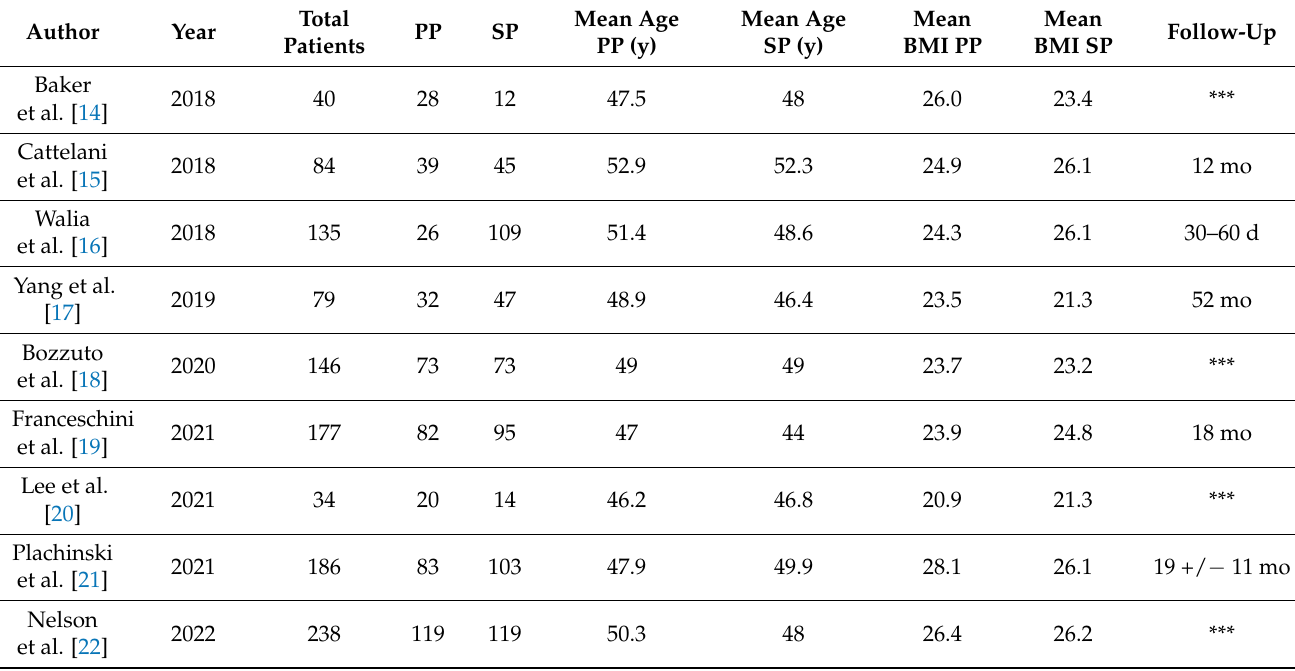
Table 2. Characteristics of the included